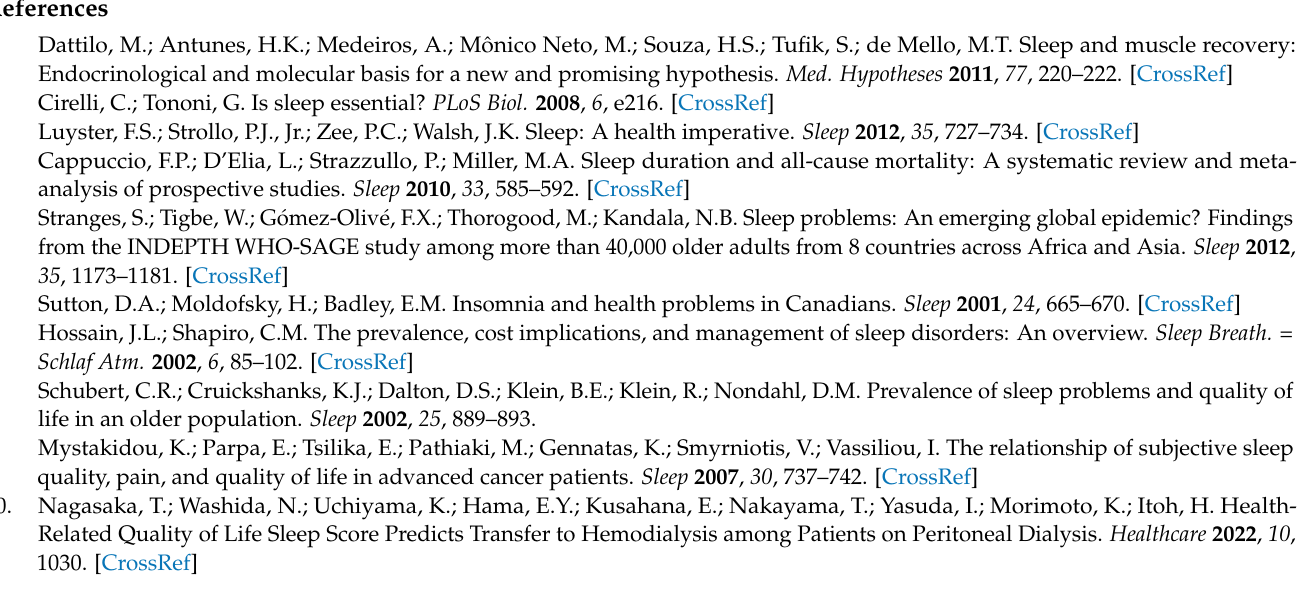
Table S6: HIRA codes for the x-rays of the